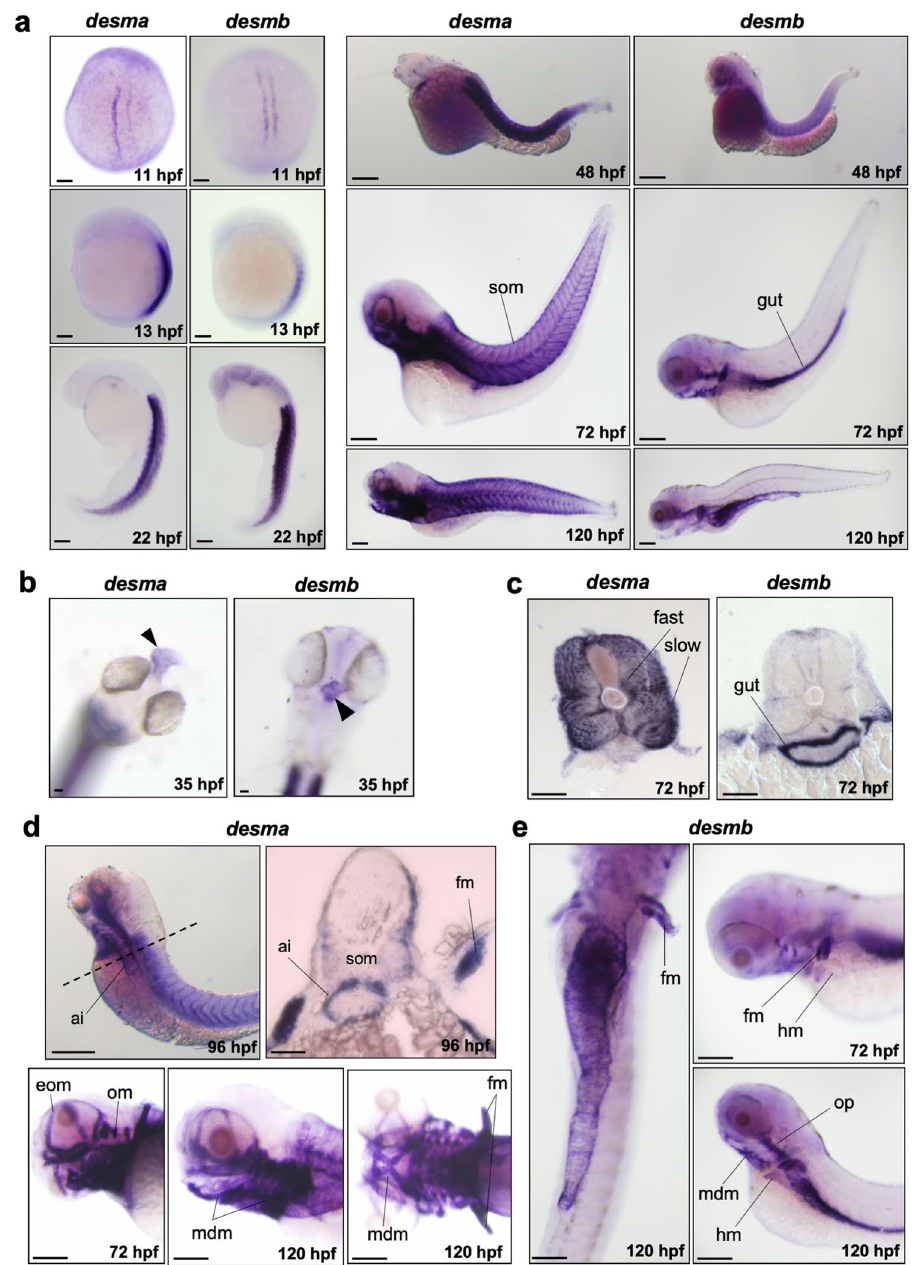
Figure 1. Whole mount in situ mRNA hybridisation of embryos at the indicated stages for antisense probes to desma and desmb . ( a ) Lateral views are anterior to top, dorsal to left for 13–22 hpf; anterior to left except 11 hpf which is a dorsal view. 48–120 hpf whole mounts are anterior to left, dorsal to top. Scale bar: 250 µm. ( b ) Arrows indicate heart in frontal view for left panel ( desma ) and ventral view for right panel ( desmb ) of 35 hpf embryos. ( c ) Transversal sections where dorsal is top. ( d ) Upper left panel is a lateral view at 96 hpf, scale bar: 250 µm. Dashed line represents the position of the transversal section in upper right panel where dorsal is top, scale bar: 100 µm. Lower panels are lateral views of zebrafish heads at 72 and 120 hpf treated with desma probe. Scale bar: 100 µm. ( e ) Left panel is a ventral view with anterior at top. Right panels are lateral views. Ai, anterior intestine; eom, extraocular muscles; fast, fast muscles; fm, pectoral fin muscles; hm, hypaxial muscles; mdm, mandibular muscles; om, opercular muscles; slow, slow muscles; som, somites. Scale bar: 250